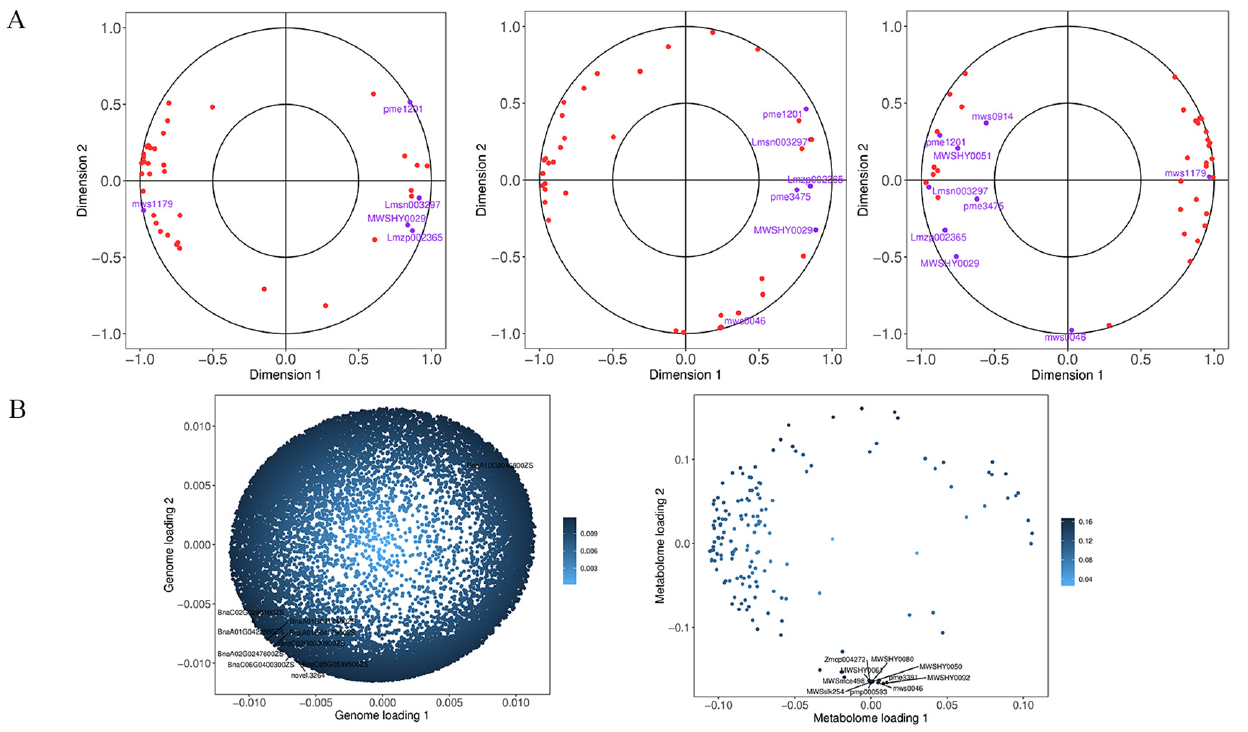
Figure 8. ( A ) Canonical correlation analysis (CCA). From left to right, Y vs. LP, Y vs. YP, Y vs. P. ( B ) Left, transcriptome loading plot; right, metabolome loading plot.